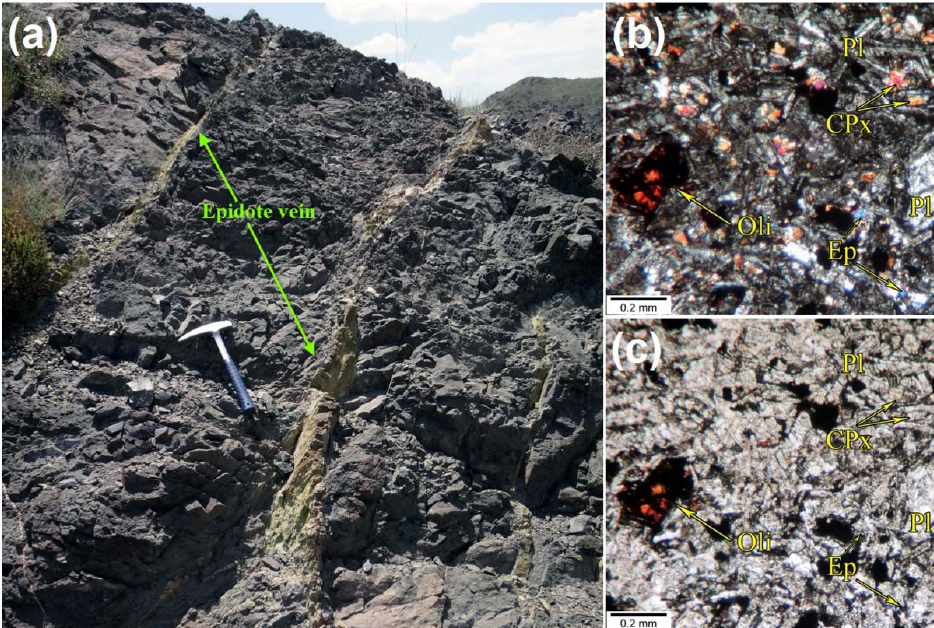
Figure 6. ( a ) Outcrop of basaltic andesite with epidote veins, ( b , c ) thin section shows olivine, plagioclase, clinopyroxene, and epidote minerals in XPL and PPL modes, respectively. Cal: calcite, CPx: clinopyroxene, Ep: epidote, Oli: olivine, and Pl: plagioclase.